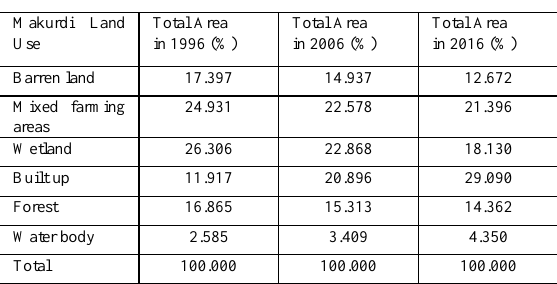
Table 6. Landuse composition of study area (%) in 1996, 2006 and 2016.